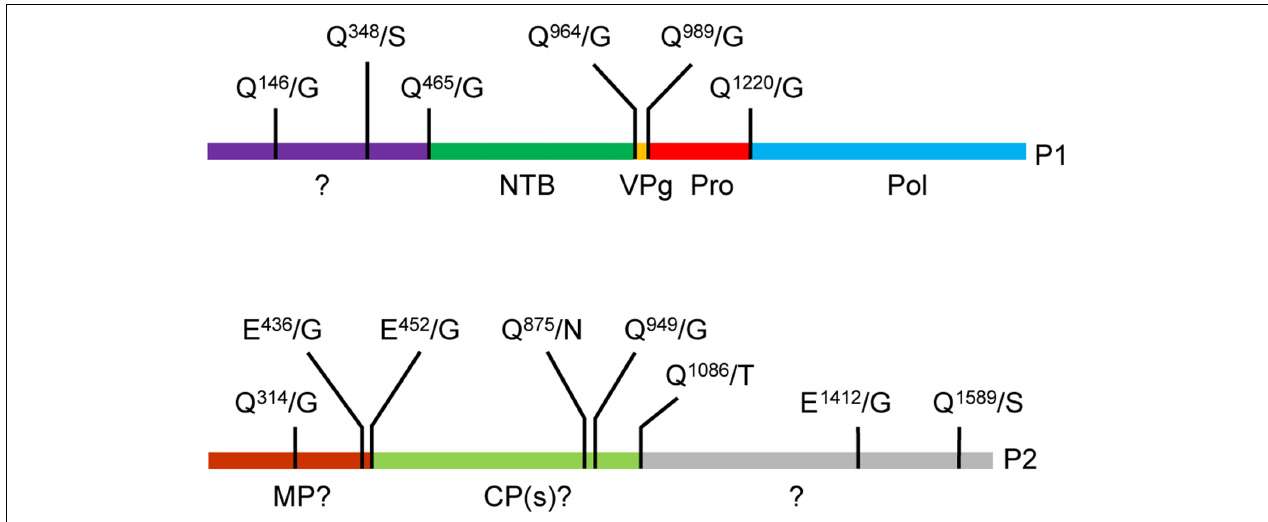
FIGURE 1 | Predicted cleavage sites in the strawberry mottle virus (SMoV) NSPer3 P1 and P2 polyproteins. Predicted cleavage sites are shown as short vertical lines above the full-length polyproteins along with the predicted cleaved dipeptide. Numbering of amino acids are defined from the beginning of each polyprotein. Please note that the numbering is identical for all SMoV isolates, although the P2 polyprotein of Netherlands isolate 1134 does not include the Q 1589 /S sequence due to a truncation of its C-terminal region. Deduced functional domains based on sequence homologies with related viruses are listed as follows. NTB, nucleoside triphosphate binding protein or putative helicase; VPg, viral genome-linked protein; Pro, protease; Pol, polymerase; MP, movement protein; CP, capsid protein.